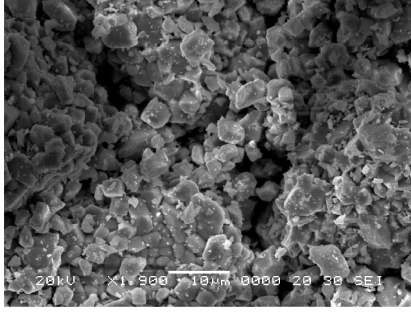
Figure 4. Scanning electron microscopy image of the synthesized AgGd(MoO 4 ) 2